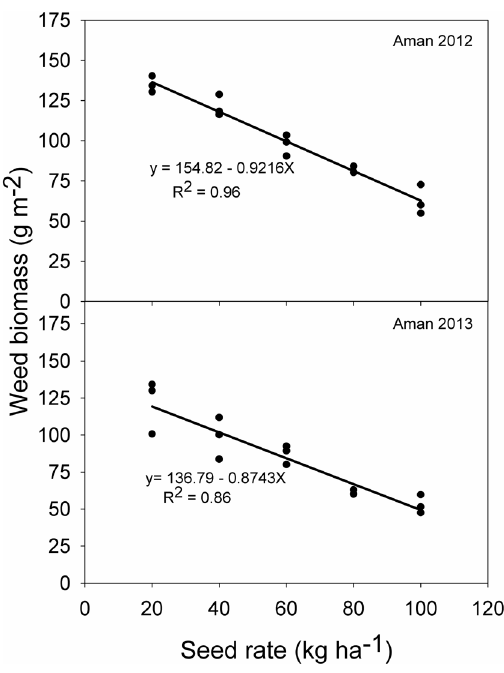
Figure 3. Relationship between rice seeding rate and weed biomass at 35 days after sowing in 2012 and 2013.